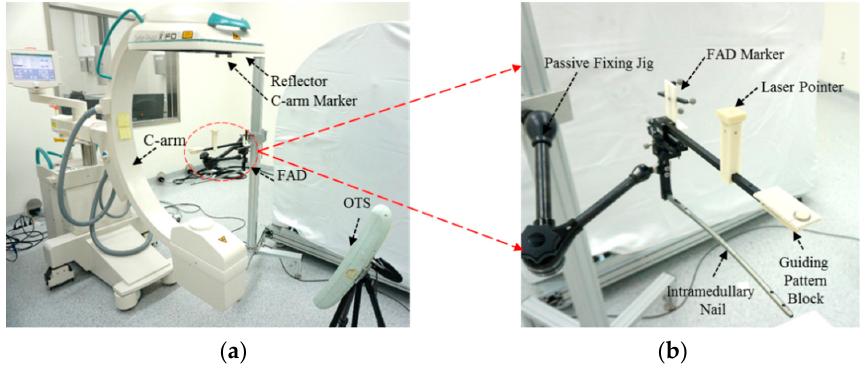
Figure 7. Experimental setup. ( a ) Whole setup. ( b ) Enlarged.